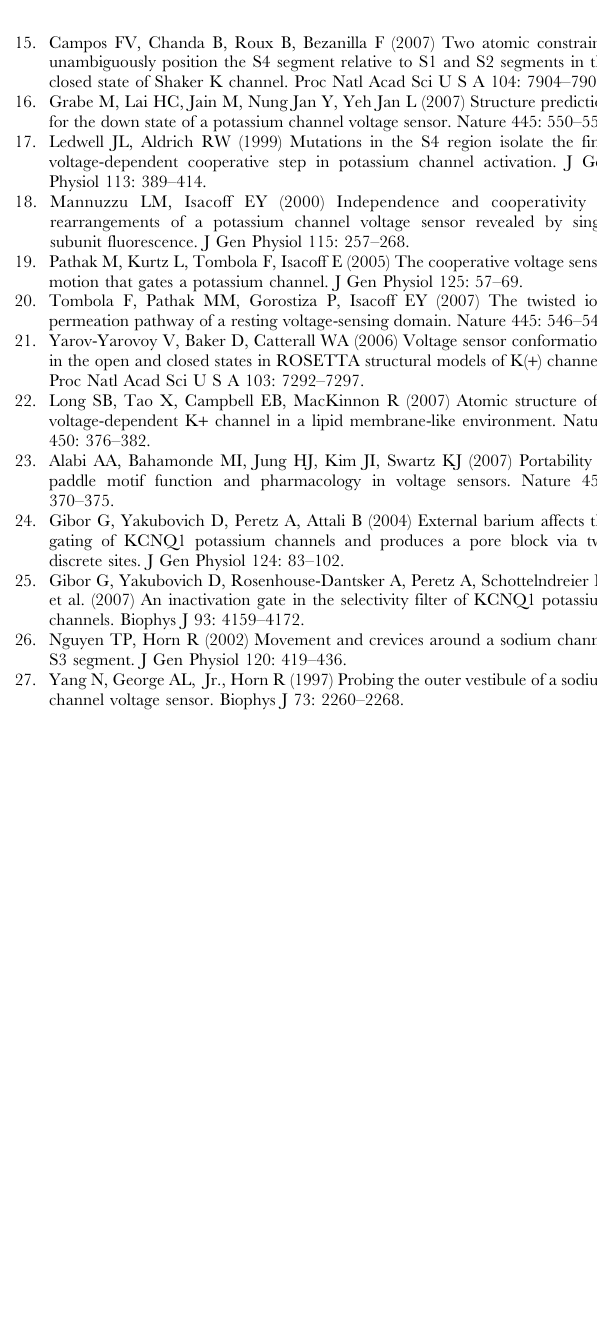
Figure 9C. Note that energy was minimized in the closed and intermediate state models and no clashes take place in these two models, as